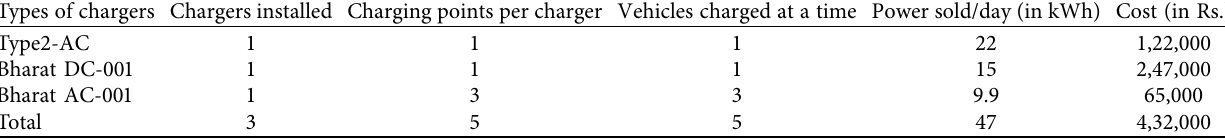
Table 11: Solar powered moderate charging station [131].